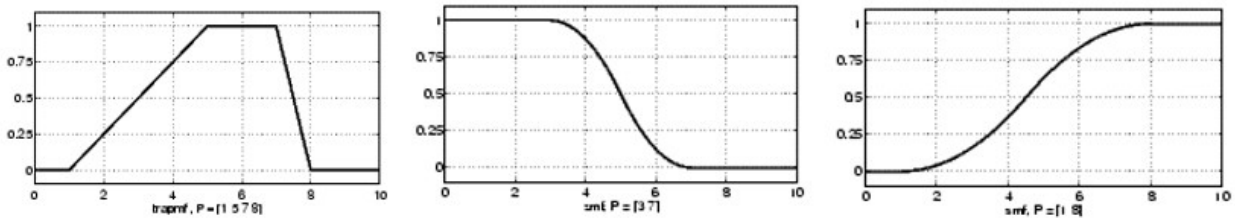
Figure 3. Fuzzy membership functions (after Mancini et al.,